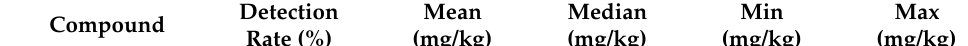
Table 1. Concentrations of Σ 15 PAEs in agricultural soil samples in coastal areas of South China.